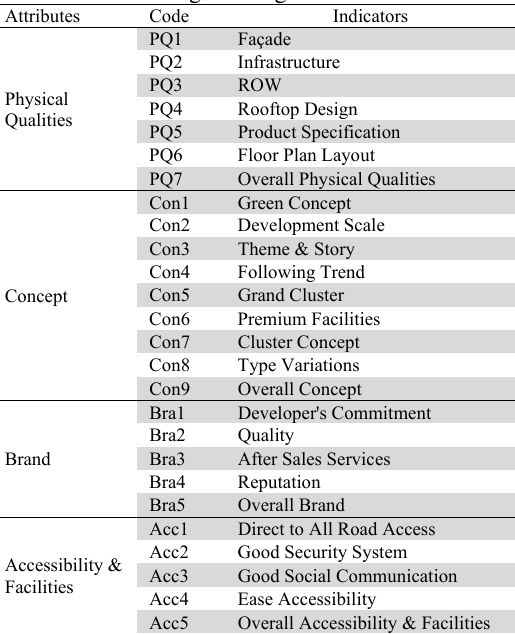
Fig. 1. Conceptual model of the study